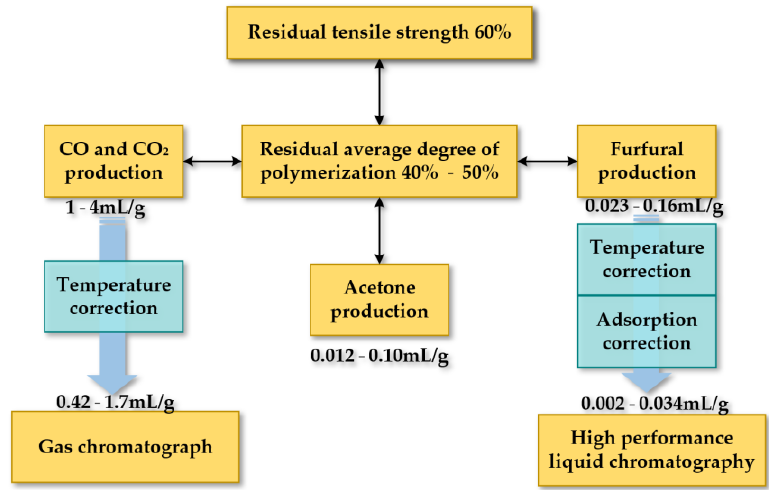
Figure 11. Relationship between acetone and aging indicators of transformer insulation.